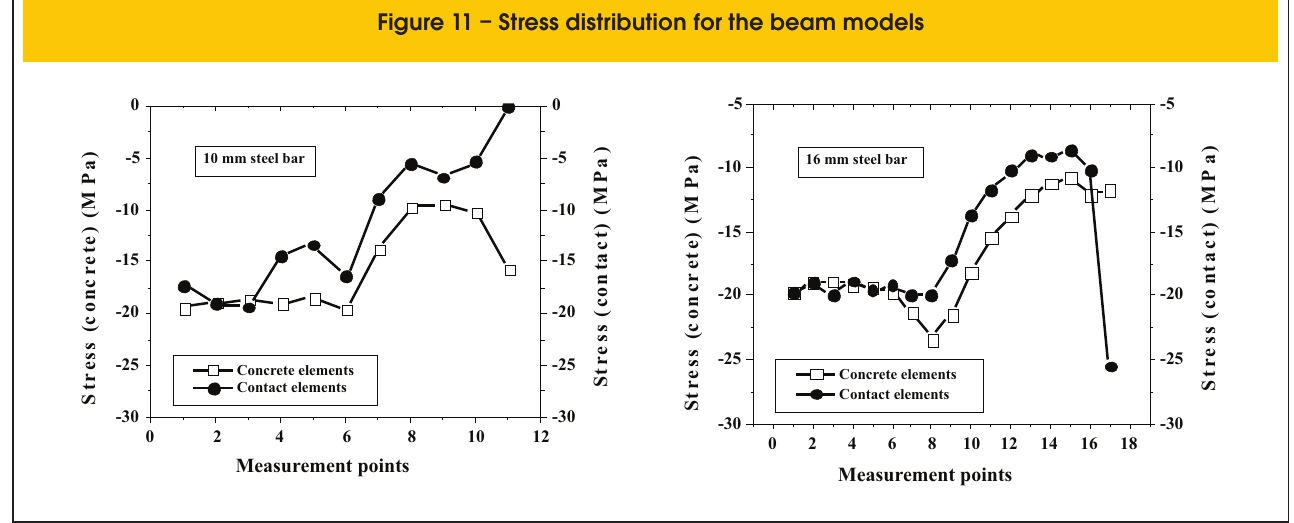
Figure 11 – Stress distribution for the beam